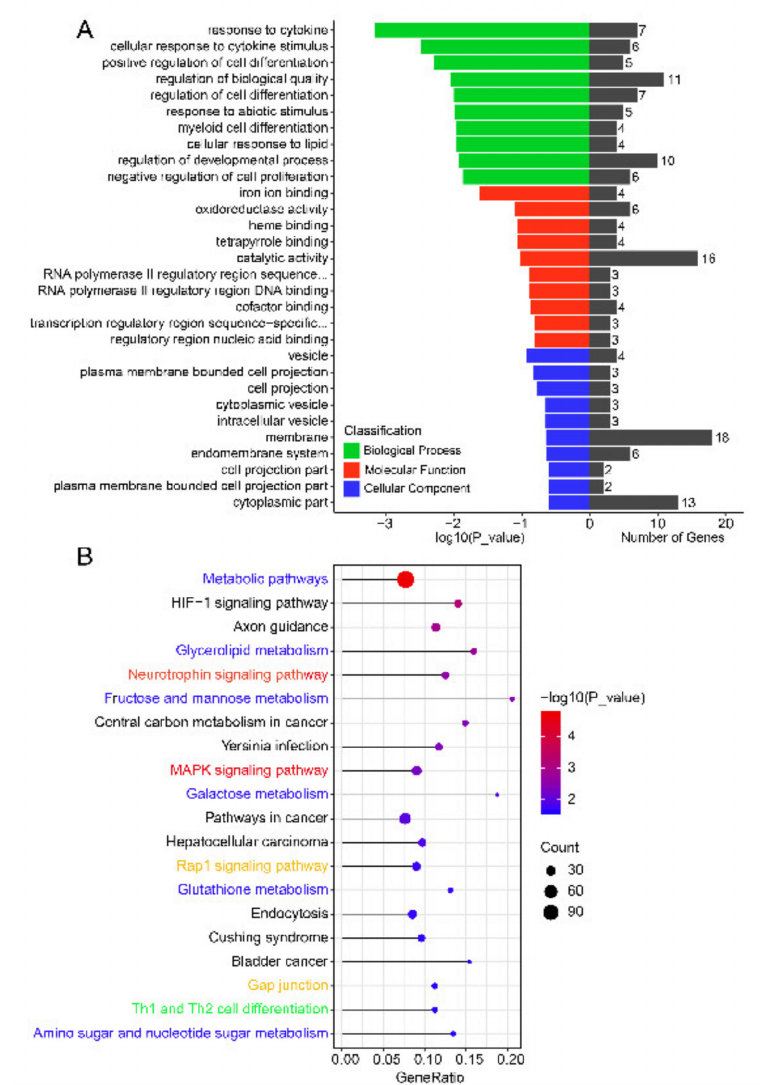
Figure 6. GO and KEGG enrichment analysis of predicted target genes of DEMs. ( A ) GO analysis of predicted target genes of SEMs. ( B ) Top 20 KEGG pathways of predicted target genes of DEMs. The x-axis indicates the ratio of the predicted target genes to the annotated genes enriched in this pathway, while the y-axis indicates the KEGG pathway. “Count” means the number of predicted target genes enriched in this pathway. The color represents the degree of enrichment, with red representing significant enrichment. The red font indicates a relationship between the pathways and endometrial development and remodeling. The yellow font indicates a relationship between the pathways and embryo implantation. The blue font indicates a relationship between the pathways and metabolism. The green font indicates a relationship between the pathways and maintenance of